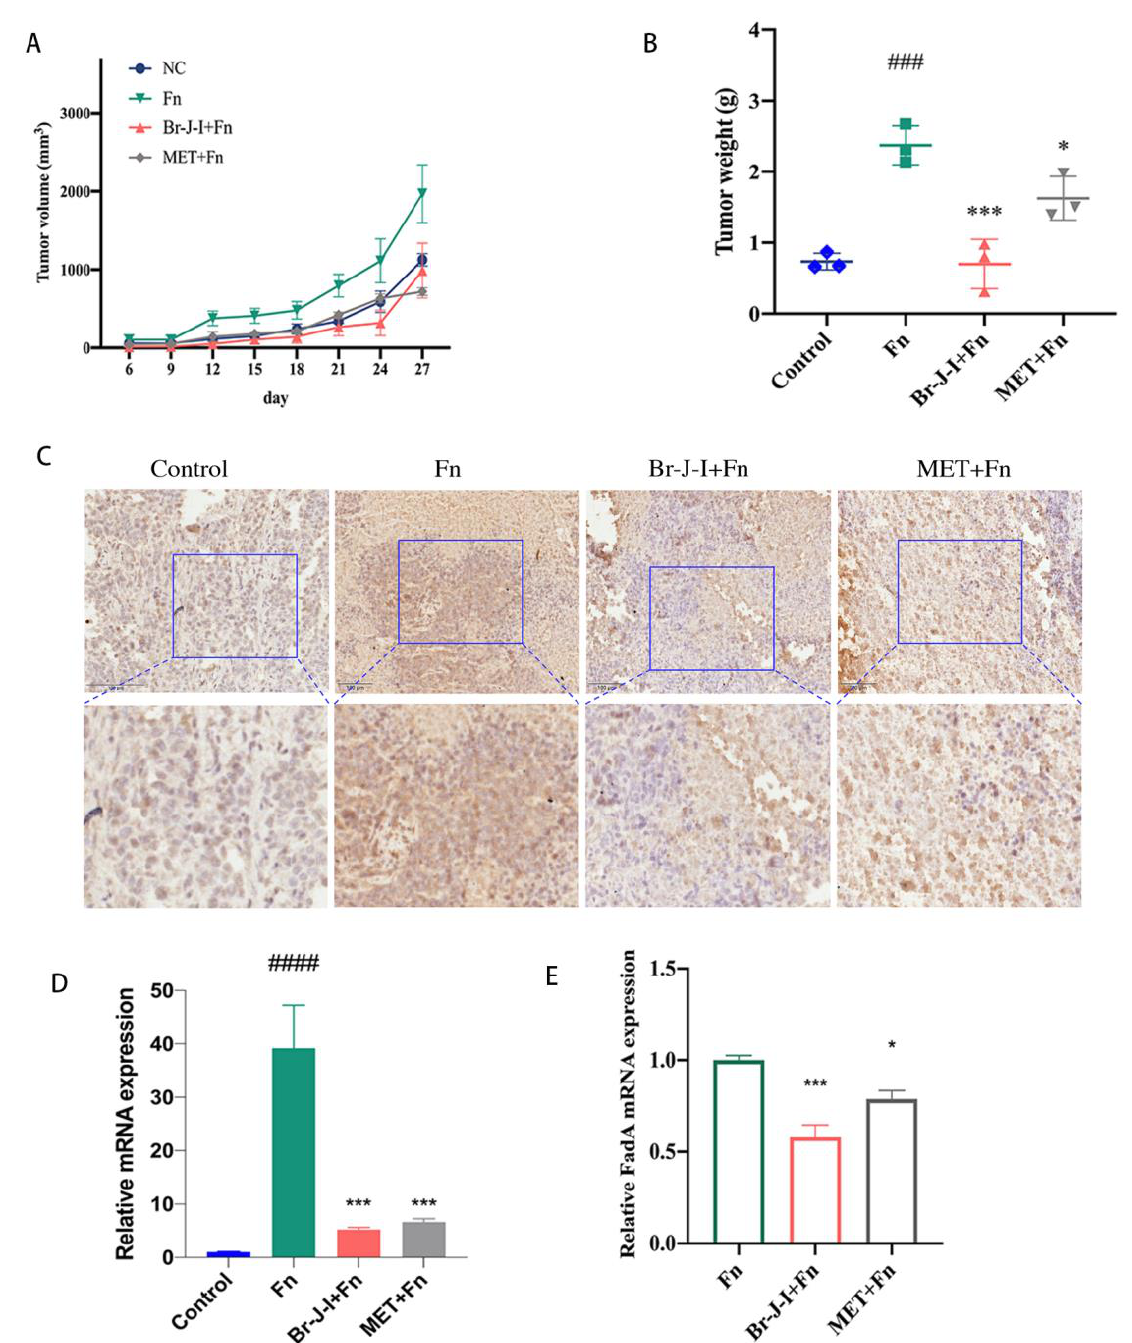
Figure 6. Effect of Br-J-I on the growth of the HCT116-xenograft tumors with intratumoral Fn colo- nization. Tumor volume ( A ) and tumor weight ( B ) of HCT116-derived tumors from the CRC mice inoculated with Fn in the presence of Br-J-I (10 mg/kg) or MET (40 mg/kg). ( C ) Immunohistochem- istry of Ki-67 + cancer cells in the HCT116-tumor xenografts after the treatments of Br-J-I (10 mg/kg) and MET (40 mg/kg), respectively. Scale bar: 100 µ m (Top), 4-fold magnification of top (Bottom). ( D ) Quantification of Fn -specific RNA in the tumors of CRC mice with or without Fn colonization in the presence of Br-J-I (10 mg/kg) and MET (40 mg/kg), respectively. ( E ) QPCR of FadA RNA in tumors of mice engrafted with HCT116 cells with Fn colonization and Br-J-I treatment. All values are represented as mean ± SEM. * p < 0.05, *** p < 0.001, vs. Fn group. ### p < 0.001, #### p < 0.0001, vs.